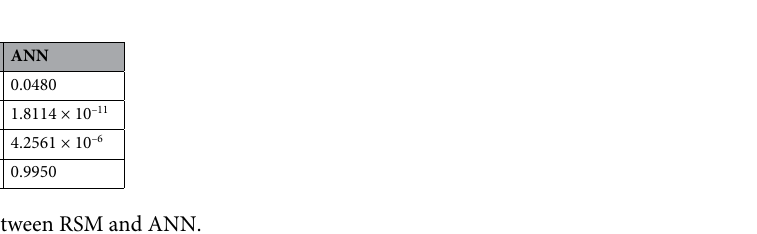
Table 6 display the simulation values obtained from the optimized ANN model. The value of the corre- lation coefficient (r 2 ALL ) of the simulated data versus the experimental data of fouling resistance was 0.9950 (r 2